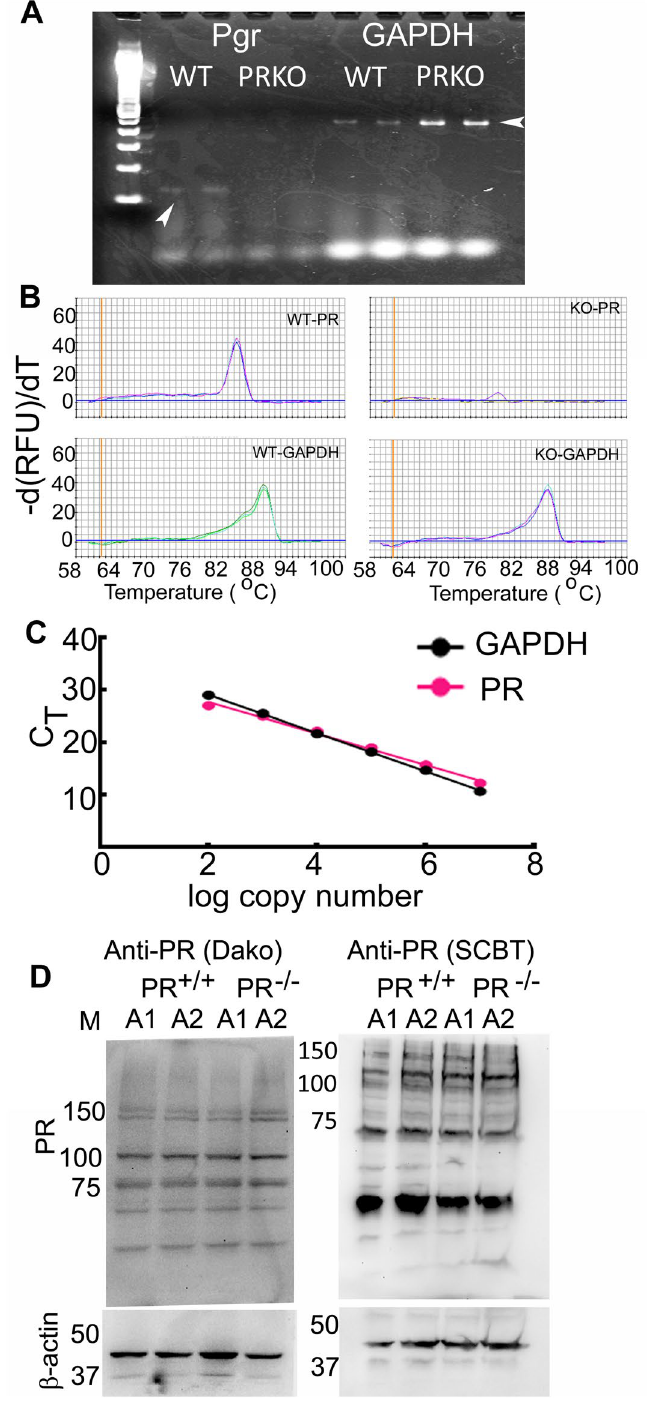
Figure 8. Validation of the qRT-PCR assay. ( A ) A PCR was performed using primers amplifying a fragment of PR and GAPDH using cDNA as a template. The PCR reaction generated a single band of the expected size in the WT animals; an amplification product was not seen in the PRKO animals. ( B ) Melting curves of PR and GAPDH qPCR from representative PRKO and WT mice. ( C ) Efficacy of amplification of PR and GAPDH primers. ( D ) Western blots of brain proteins using two anti-PR antibodies. The expression of β-actin was used as a loading control. Molecular weight markers are shown in lane M. Please note that the antibodies reacted with multiple proteins suggestive of lower specificity. The β-actin blot is cropped to show only the signal, full blot is included as a supplementary